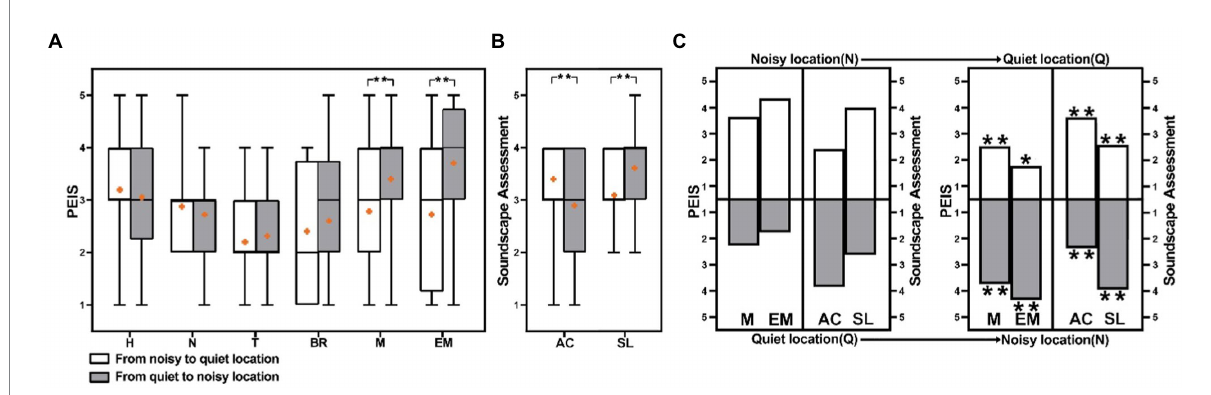
FIGURE 8 Comparison of PEIS and the soundscape assessment in sound loudness contrast paths (A) comparison of PEIS in sound loudness contrast paths, (B) comparison of the soundscape assessment in sound loudness contrast paths, and (C) comparison of each location PEIS and soundscape assessment in sound loudness contrast paths. (H, Human sound; N, Natural sound; T, Traffic noise; BR, Broadcast sound; M, Music; EM, Electro- mechanical sound; AC, Acoustic comfort; SL, Subjective loudness; * p < 0.05, ** p < 0.01; (C) : * p , ** p : correlation between PEIS of each location and overall PEIS, Assessment of each location and overall Assessment).